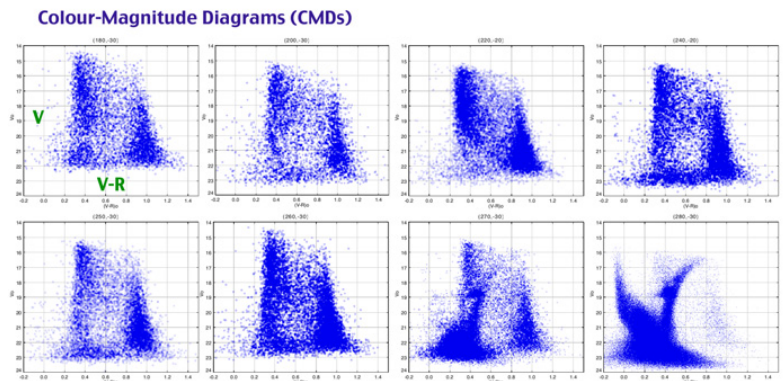
Figure 2. Example Colour-Magnitude Diagrams from around the survey in V and R bands. Several fields have clear detections of the Thick disk of the Milky Way and also the distant Monoceros Ring. In the region near the Large Magellanic Cloud, we can also trace these stellar populations in impressive